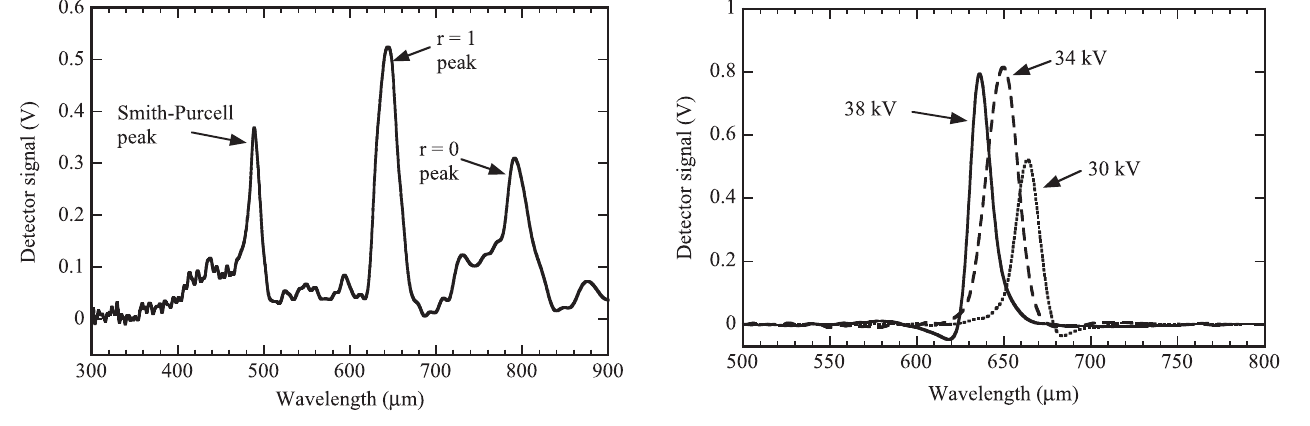
FIG. 6. The r ¼ 1 mode shifts to shorter wavelength with increasing voltage as predicted. Spectra were collected at the upstream end of the grating.